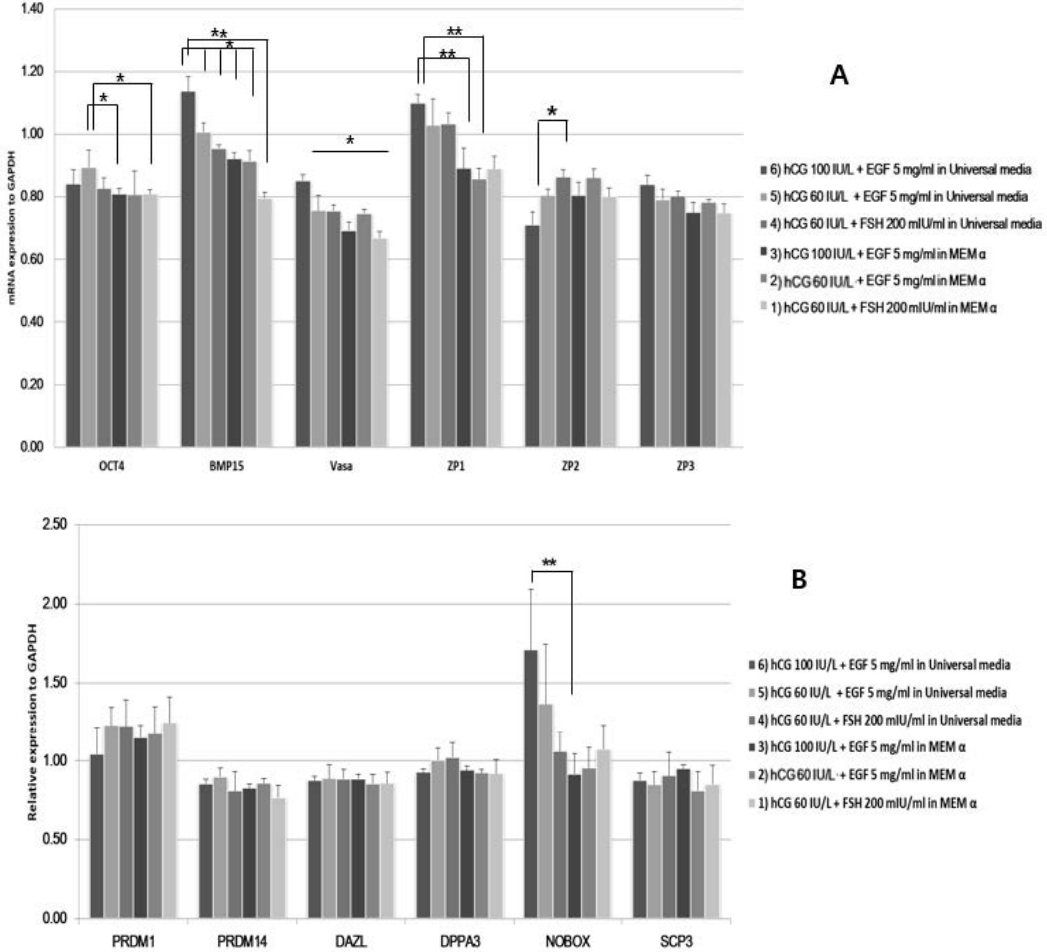
Figure 5. MicroRNA (mRNA) expression of marmoset single oocytes from different in vitro maturational conditions. Developmental gene expression of oocytes (A) and of primordial germ cells (B) was evaluated using qPCR. BMP15 and ZP1 were highly up-regulated in the ‘condition 6 ′ group, and Novox was also up-regulated. ** p < 0.05.